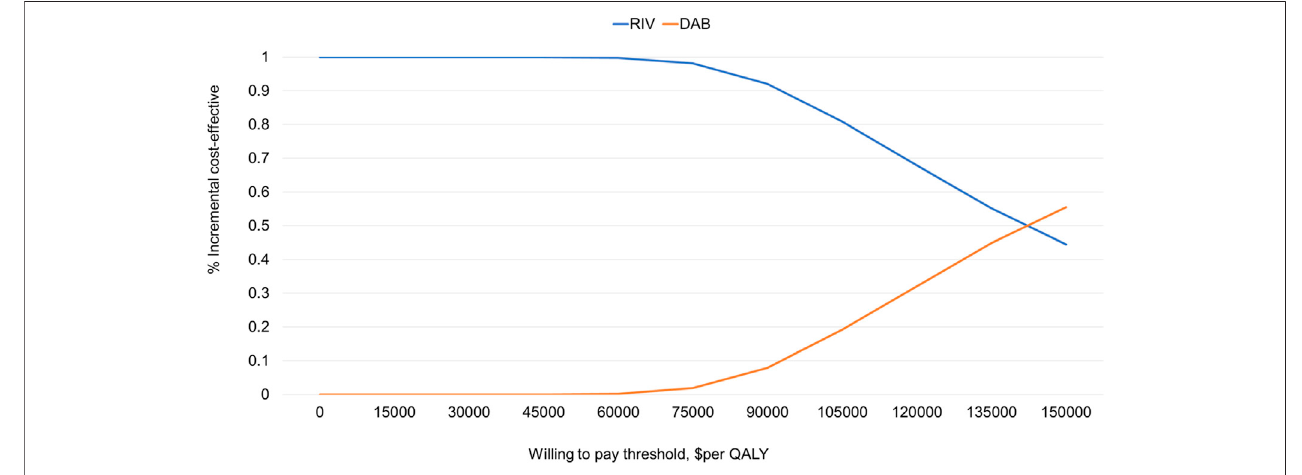
FIGURE 3 | Cost-effectiveness acceptability